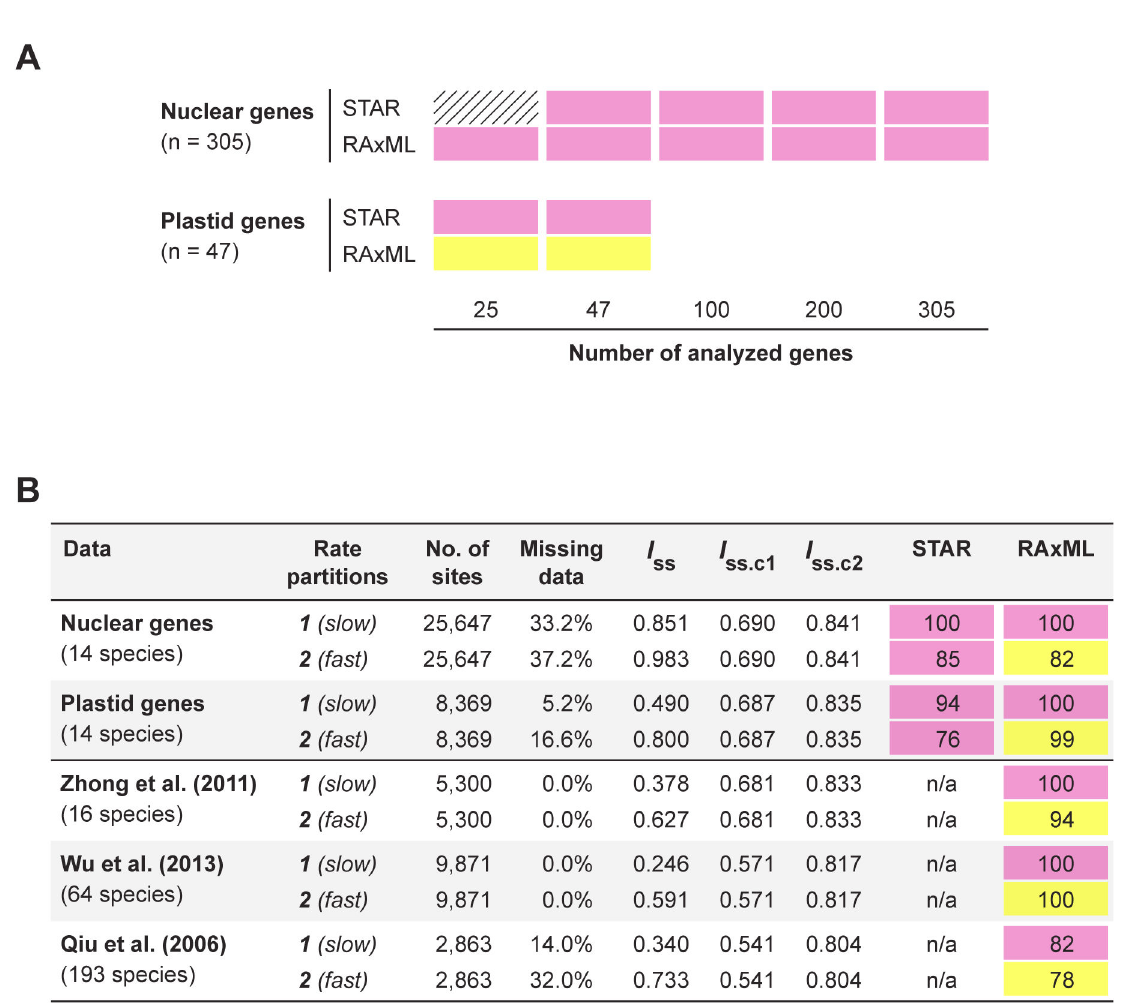
) was used to measure SS values, i.e., I and I , were estimated SS SS.C1 SS.C2